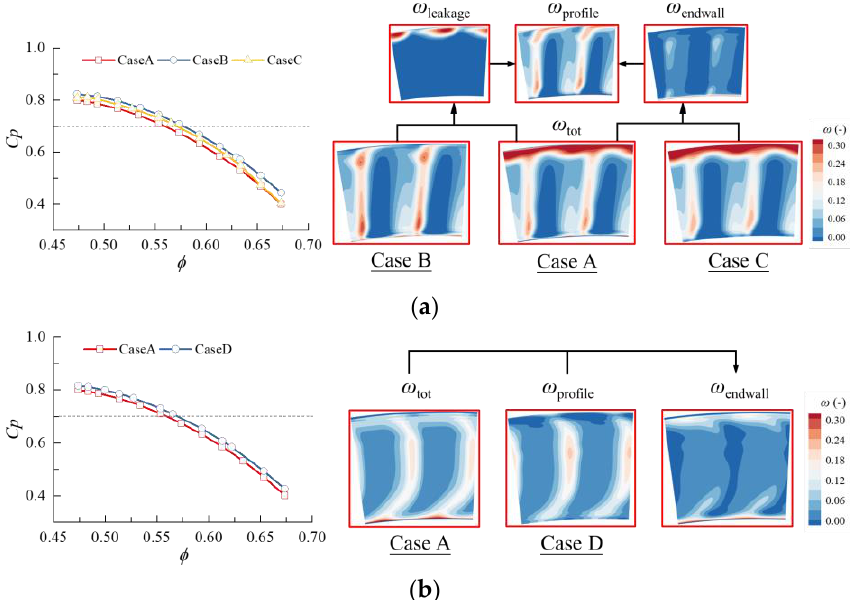
Figure 15. Demonstration of the loss decomposition results: ( a ) rotor loss decomposition; ( b ) stator loss decomposition.